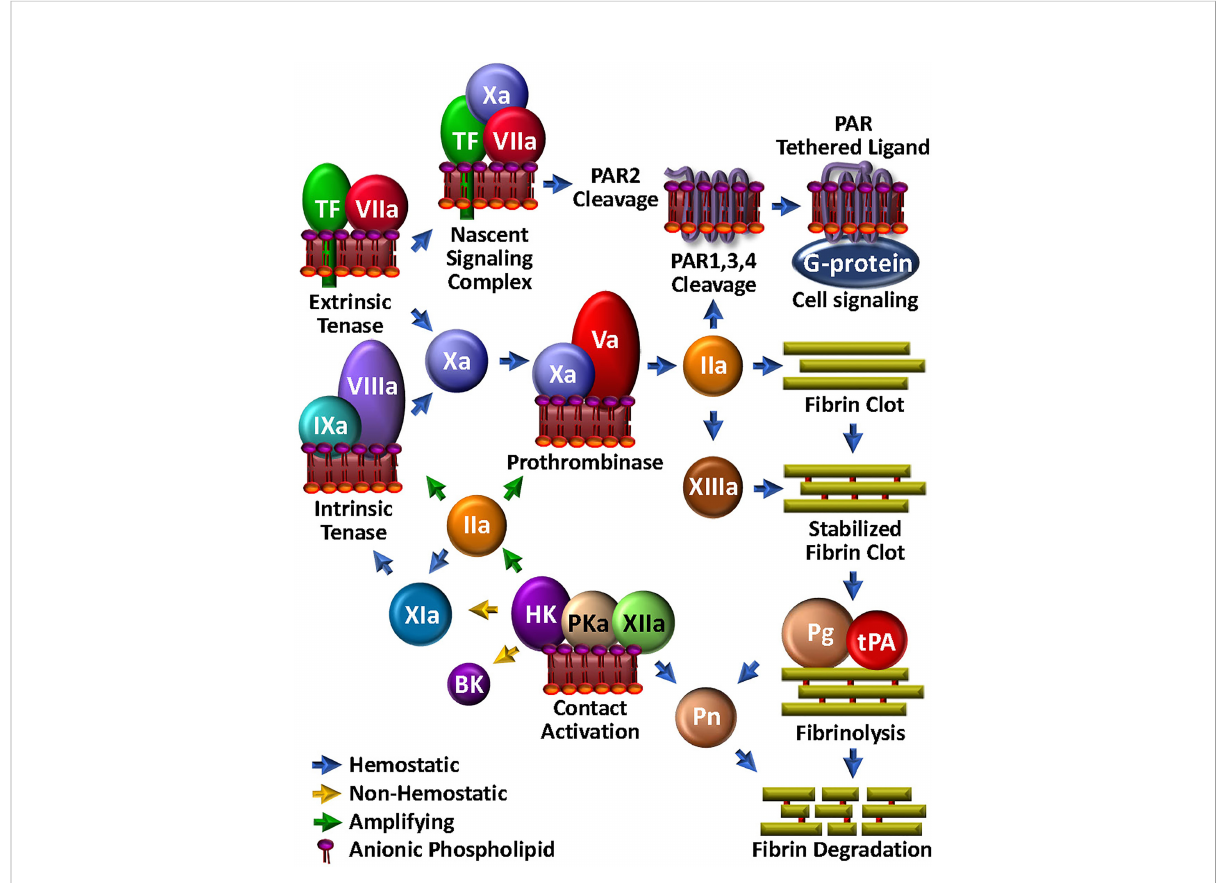
FIGURE 1 Coagulation Unwebbed. Upon vascular damage, hemostatic coagulation is initiated by exposure of TF and assembly of the extrinsic tenase, leading to prothrombinase and ultimate thrombin (IIa) production, which is responsible for direct fi brin clot formation and feedback ampli fi cation involving the intrinsic tenase. The nascent TF/FVIIa/FXa complex and thrombin facilitate PAR-mediated cell modulation. FXIIIa crosslink-stabilizes the clot. Initiation and ampli fi cation of coagulation may be facilitated by the so-called intrinsic coagulation/contact pathway. Clot degradation and solubilization is facilitated by the fi brinolysis pathway through tPA-mediated plasminogen (Pg) activation to plasmin (Pn), which can be enabled by kallikrein